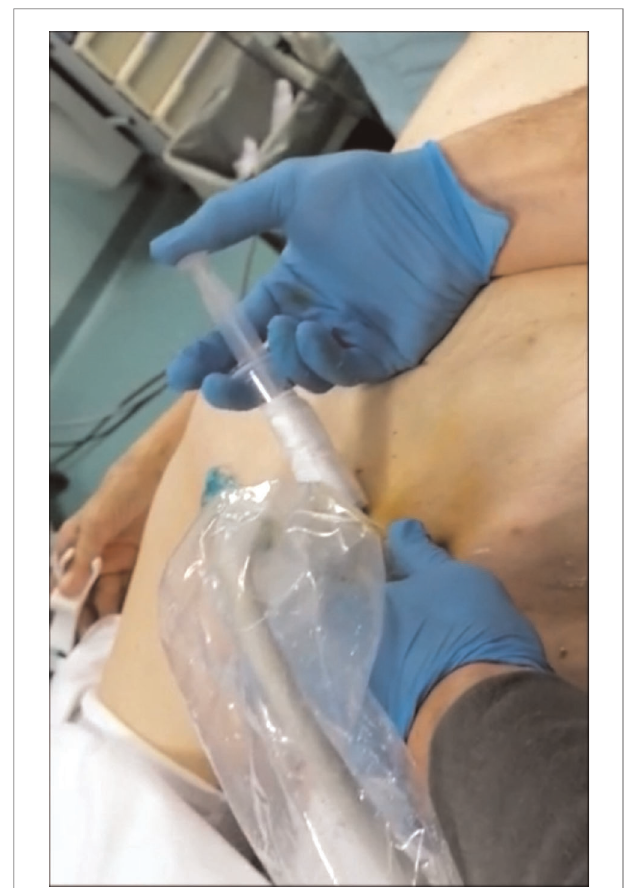
FIGURE 1 | A dose 0.5 mg/kg of ICG is injected percutaneously bilaterally in the super fi cial inguinal nodes under ultrasound visualization. This procedure is performed before thoracoscopy in total esophagectomy, or after laparoscopic time in Ivor Lewis